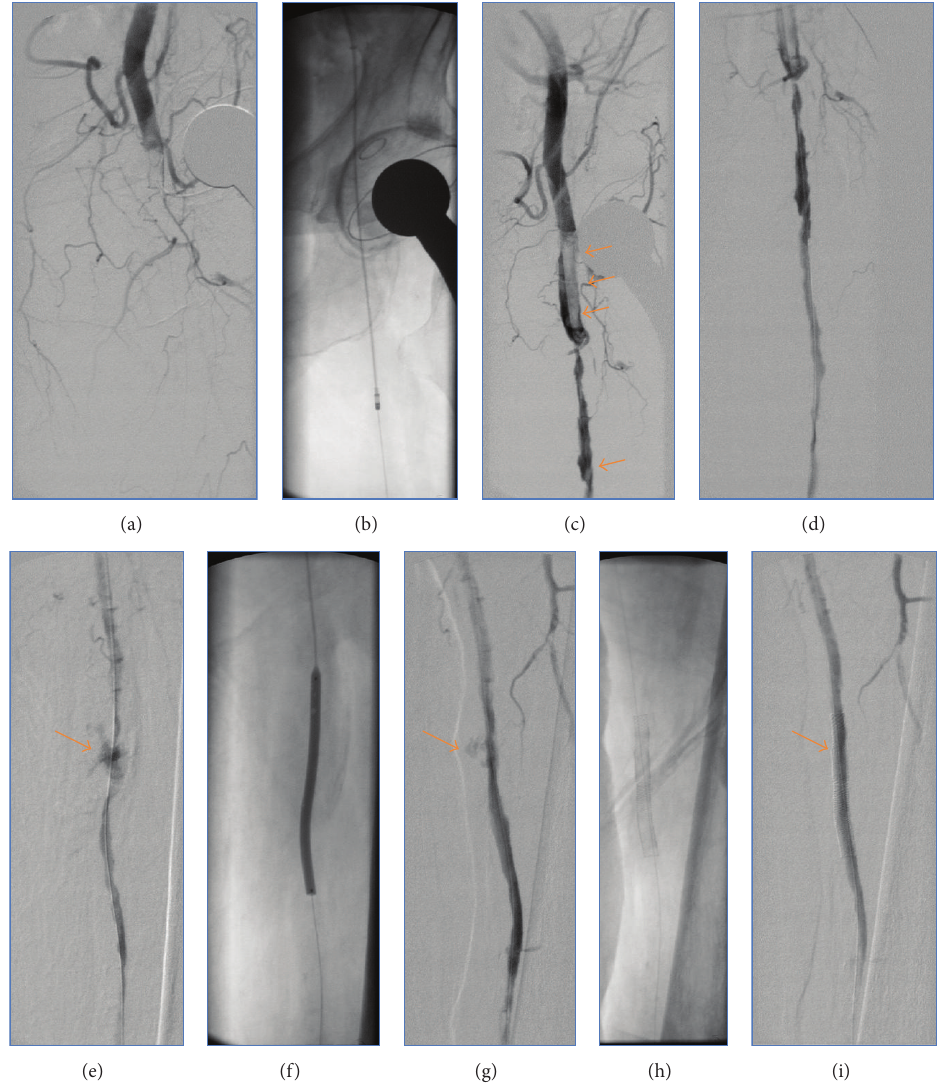
Figure 2: Occlusion of the CFA is noticed by DSA (a). Rotarex catheter thrombectomy reestablishes antegrade flow in the CFA and SFA (b), but thrombotic burden remains high as it can be appreciated by the orange arrows in (c). Mid and distal parts of the SFA with thrombus formations can also be appreciated in (d). After repeated Rotarex thrombectomy a perforation of the SFA is noticed, with persistent despite prolonged balloon inflation (orange arrows in (e)–(g)). Subsequently, 2 overlapping nitinol Supera stents are implanted (h), resulting in complete cessation of the bleeding complication (orange arrow in